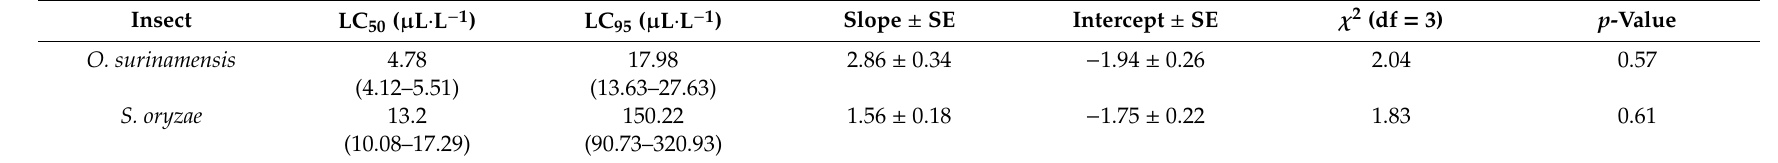
Table 3. Lethal concentration values of T. kotschyanus essential oil on O. surinamensis and S. oryzae .